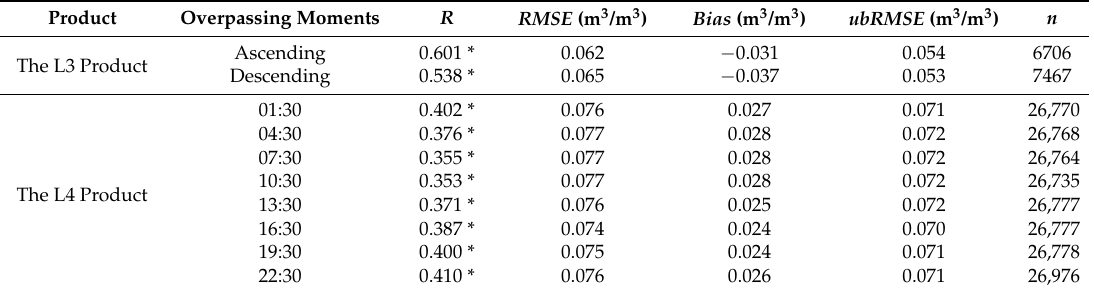
Table 2. Evaluation of the Soil Moisture Active Passive (SMAP) L3 and L4 products in the study area.